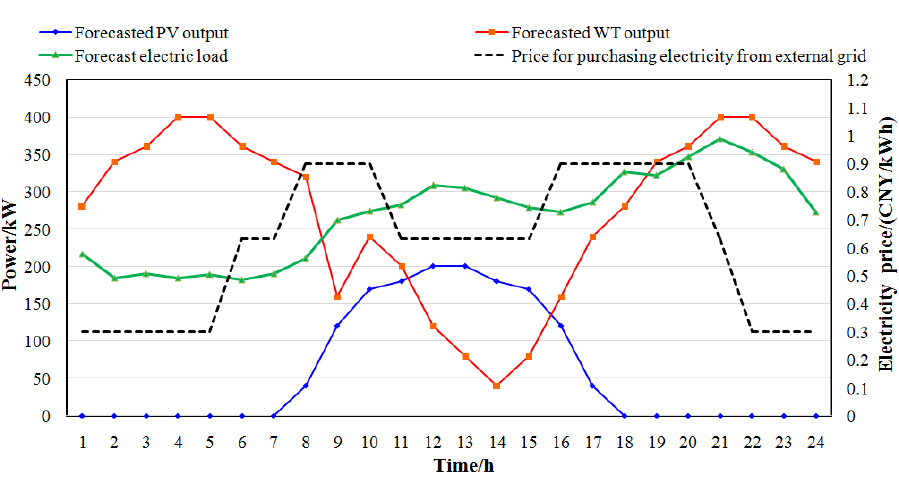
Figure 5. Forecasted curves of WT output, PV output, electric load, and electricity price curve.